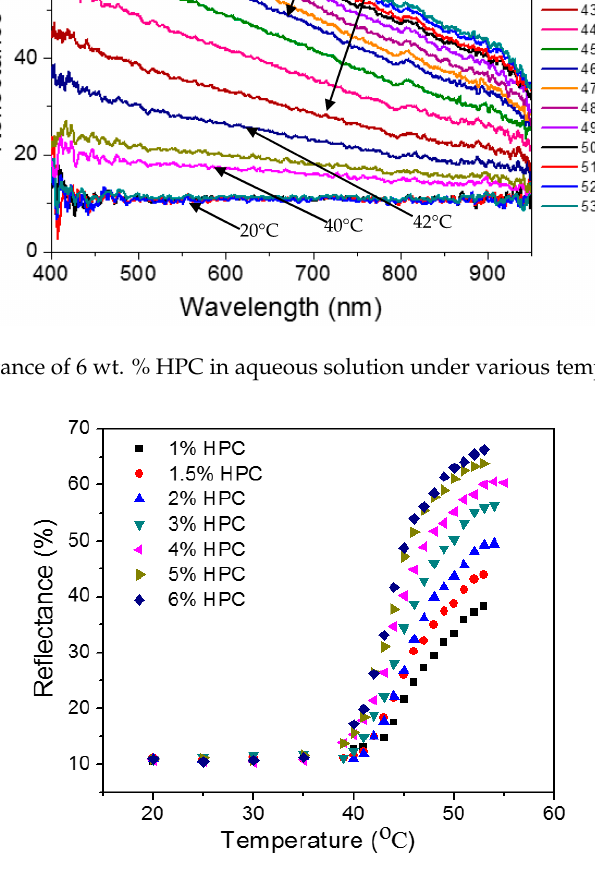
Figure 8. The variation of the reflectance under spectra of 600 nm of the selected wt. % of HPCs under different temperature.